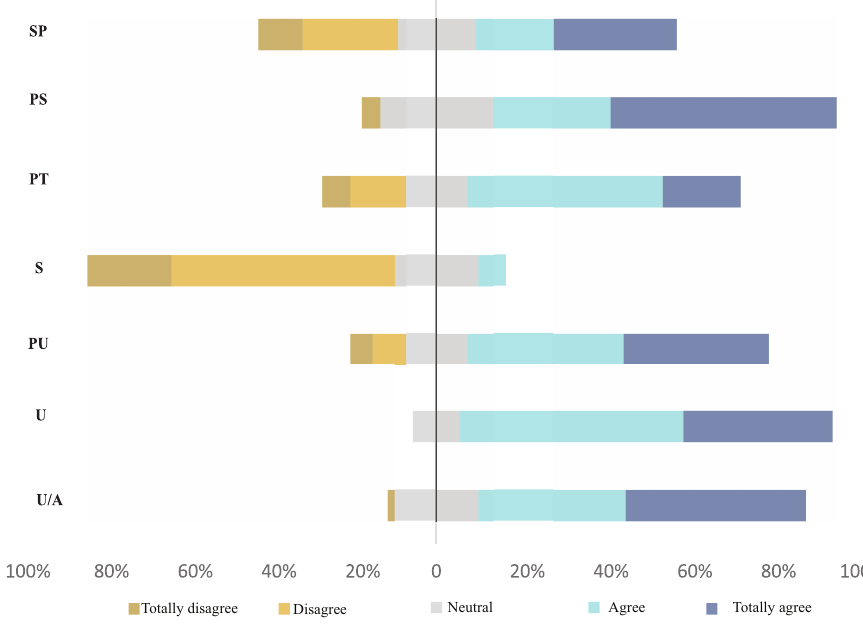
Figure 6. Likert scale distribution for each construct of the acceptance and perception questionnaire applied to